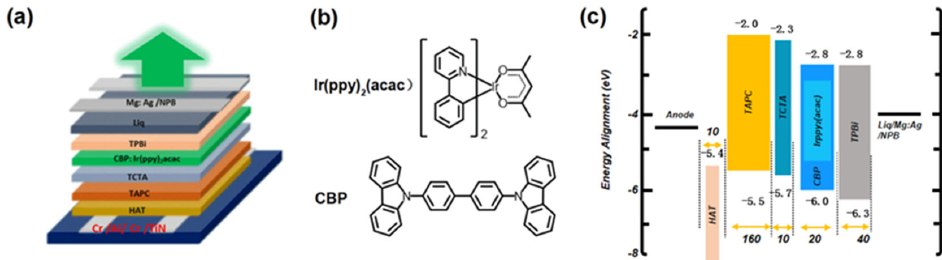
Molecules 2022 , 27 , x FOR PEER REVIEW 8 of 11 Figure 6. ( a ) Schematic structure of TE-OLED using the Cr/Al/Cr/TiN anode; ( b ) molecular struc- tures of Ir(ppy) 2 (acac) and CBP; ( c ) energy band diagram of the device. Figure 6. ( a ) Schematic structure of TE - OLED using the Cr/Al/Cr/TiN anode; ( b ) molecular struc ‐ tures of Ir(ppy) 2 (acac) and CBP; ( c ) energy band diagram of the device.